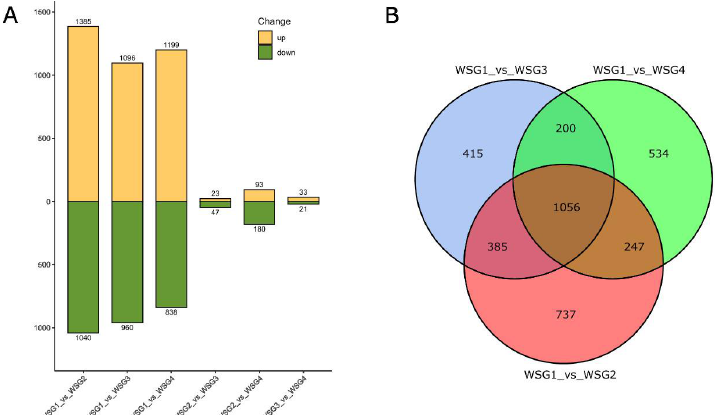
Figure 1. Differently expressed genes (DEGs) of comparison pairs. ( A ) Up- and down-regulated genes in all possible comparisons of diapausing larvae (WSG1) and larvae that were exposed to 4, 8, and 12 days of long day and high temperature conditions in the laboratory (WSG2, WSG3, WSG4 respectively). The numbers on the top and bottom of each end of the bar indicate the quantities of up- and down regulated DEGs. ( B ) Overview of DEG comparisons of WSG1 versus WSG2, WSG1 versus WSG3, and WSG1 versus WSG4. WSG1 was regarded as the control. The numbers within the circles indicate the DEG quantities.